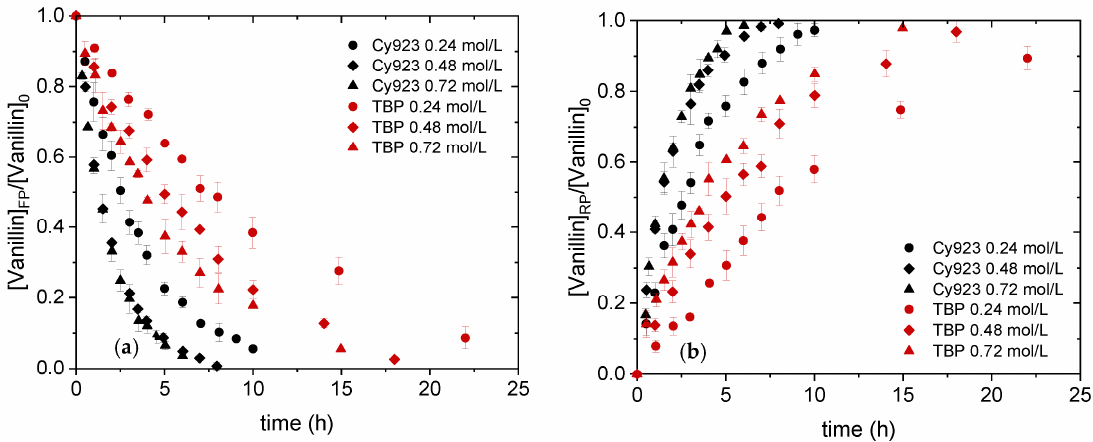
Figure 5. Effect of carrier concentration on the vanillin transport in the Feed phase (FP) ( a ) and in the receiving phase (RP) ( b ). FP: 100 mg/L vanillin in cb pH 4; RP: 0.50 mol/L